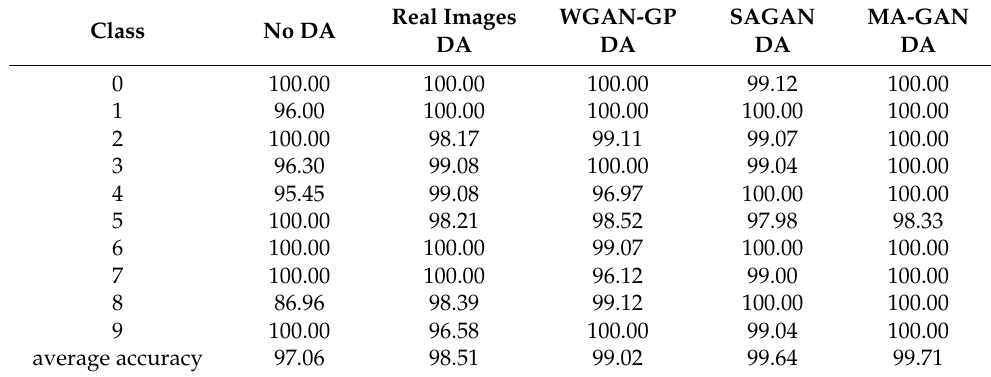
Figure 14. Classified accuracy of the training set and testing set ( a ) before and ( b ) after CIFAR- 10 augmentation. Table 10. Classified accuracy of MNIST training set after augmentation by different methods (%).